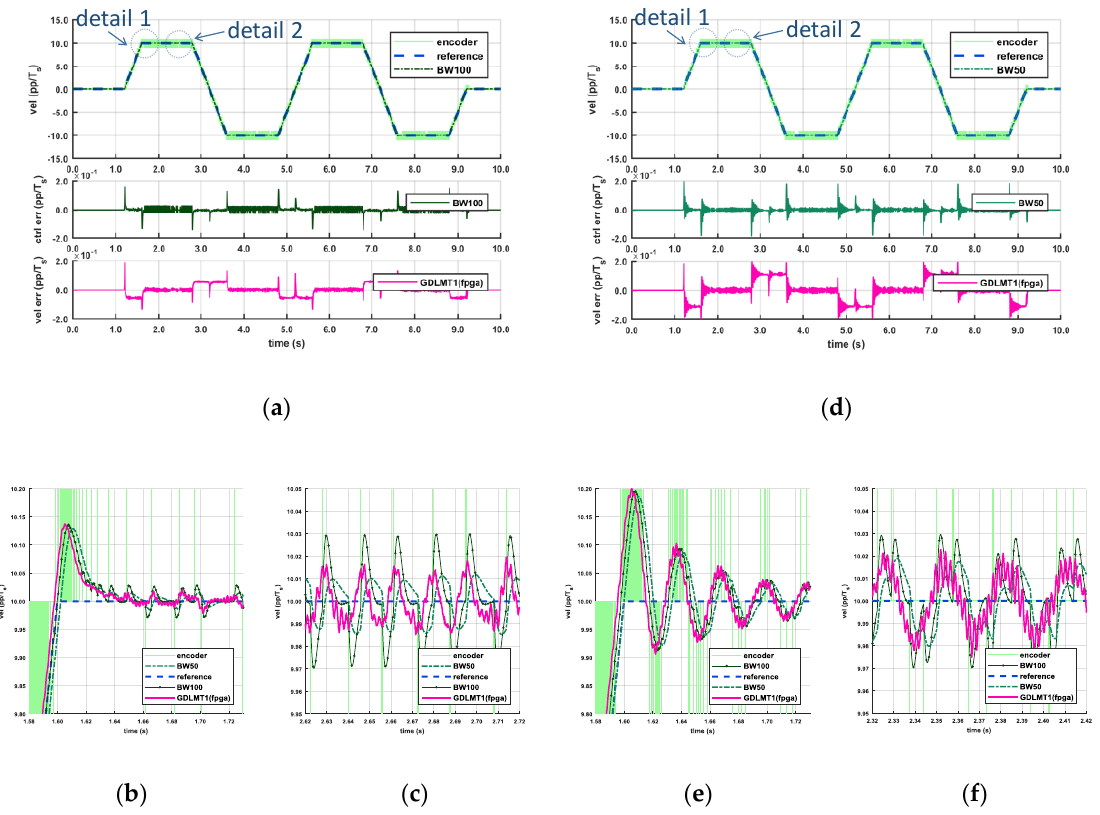
Figure 14. The motor experiment a Butterworth filter in the feedback: ( a ) Cut-off frequency 100 Hz; ( b )–( c ) Details 1 and 2 from (a); ( d ) Cut-off frequency 50 Hz; ( e )–( f ) Details 1 and 2 from (d).